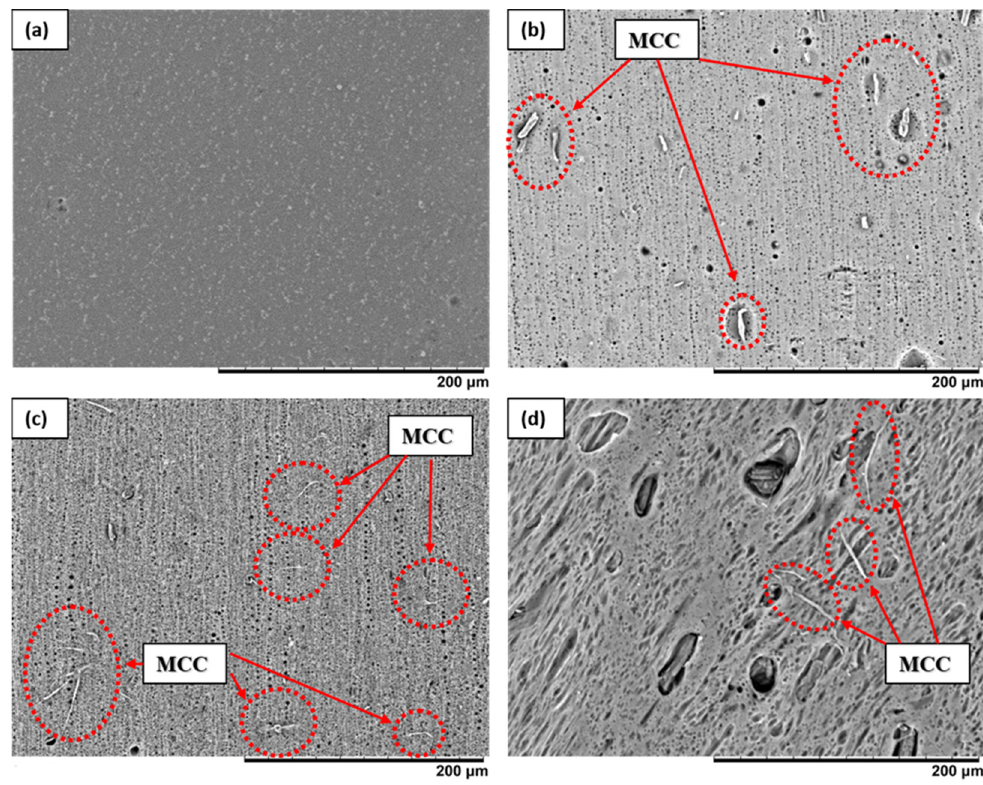
Figure 5. SEM for the top surface image of ( a ) pristine PES and MCC-incorporated PES membranes with ( b ) 1 wt.% MCC, ( c ) 3 wt.% MCC, and ( d ) 5 wt.% MCC at 500× magnification. Different pore structures were recorded when using 3 wt.% and 5 wt.% MCC loading.